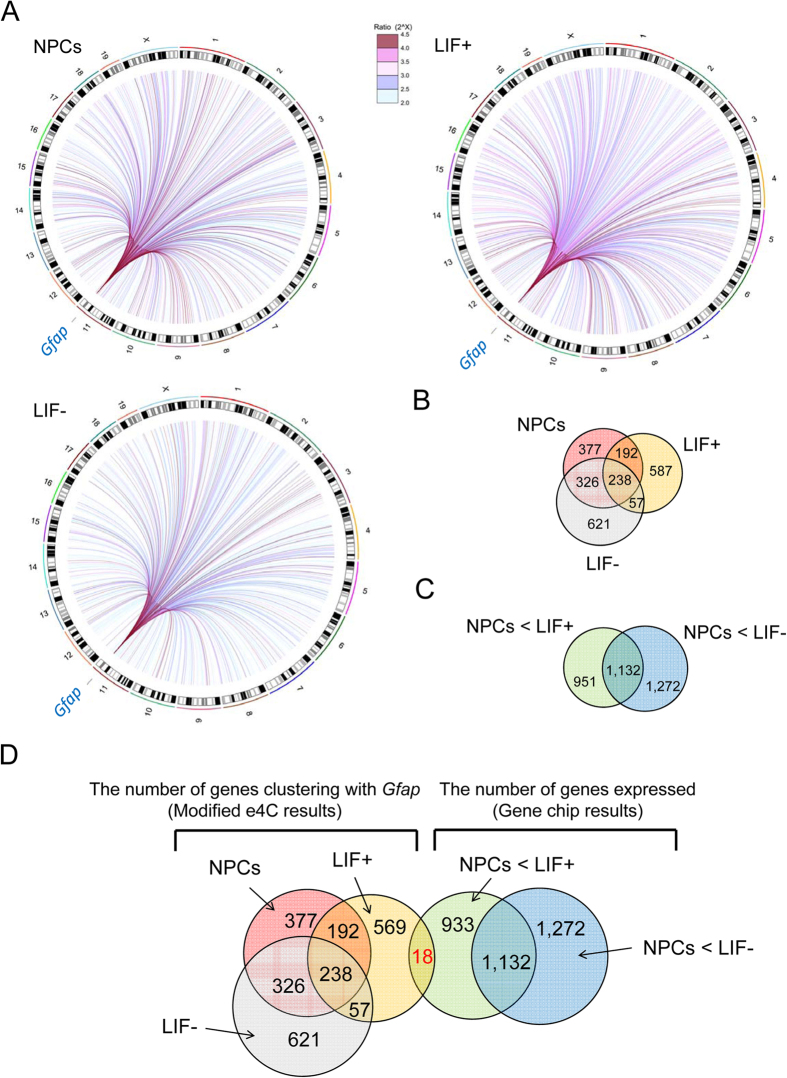
Identification of putative genes specifically associated with Gfap and expressed in LIF+ cells.(A) Circos plots showing interactions between the Gfap locus and interacting partners, with each line representing an interaction. Chromosomes are plotted along the circle. These plots were generated using the R package. The results of NPCs, LIF+, and LIF− cells are shown separately. Each line color represents the ratios of intensities of peaks compared to genomic controls. (B) Venn diagram of the Gfap-associating BglII fragments from e4C results in NPCs, LIF+, and LIF− cells. (C) Venn diagram of the genes expressed more highly in either LIF+ or LIF− cells than NPCs. (D) Venn diagram of 587 genes specifically associated with Gfap in LIF+ cells and 946 genes specifically expressed in LIF+ cells.